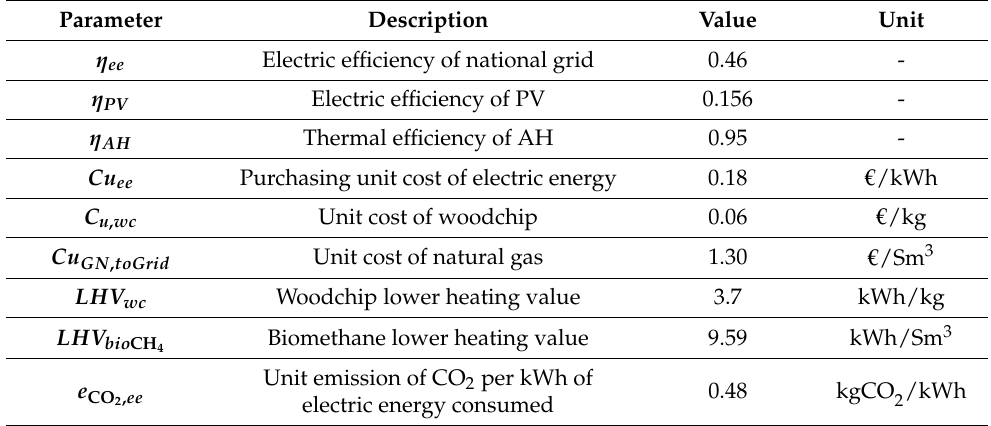
Table 2. Parameters used in energy, environment and economic analyses.